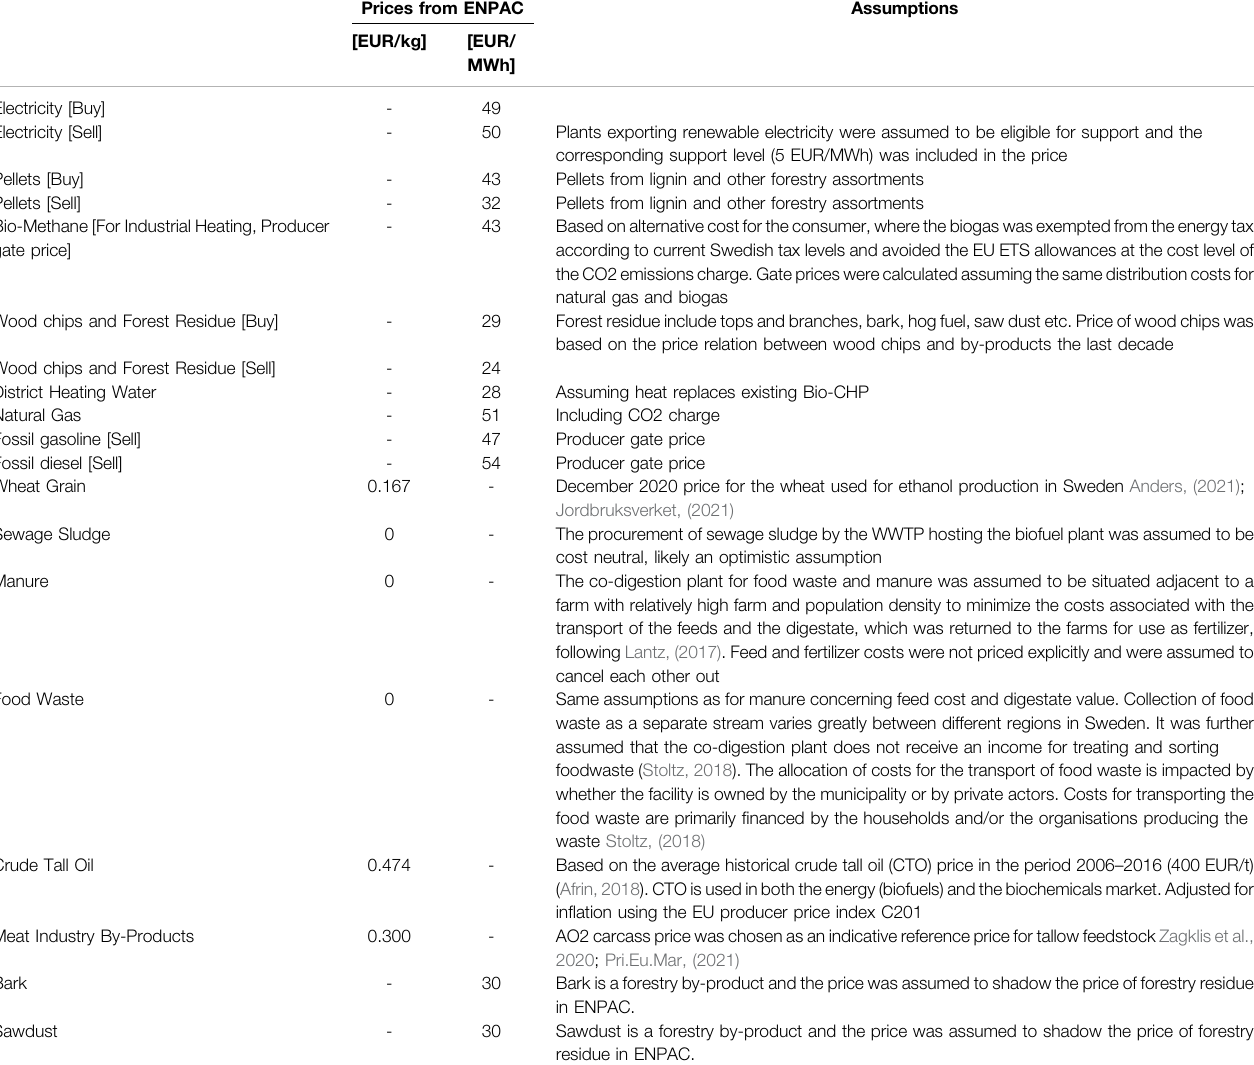
TABLE 5 | Prices for energy and material streams. Prices from ENPAC